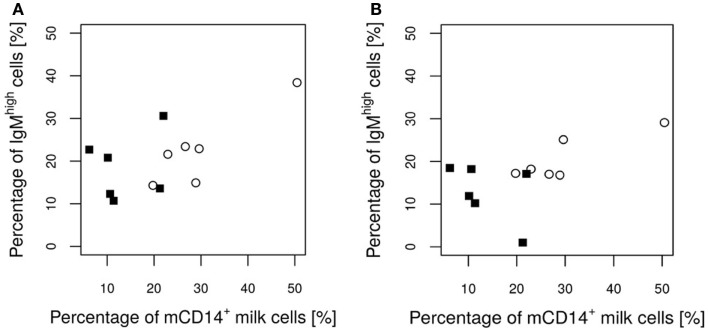
Percentage of IgM+ cells in the IL MLN of the piglets after weaning in relation to the CD14 value of the attendant sow milk measured on day 17 of lactation. Values of the control group and the E. faecium group are pictured with filled squares or blank circles, respectively. At day 34 (A), a significant positive correlation (P = 0.025) exists. On day 54 (B), the P-value indicates a tendency (P = 0.065) for a positive correlation.